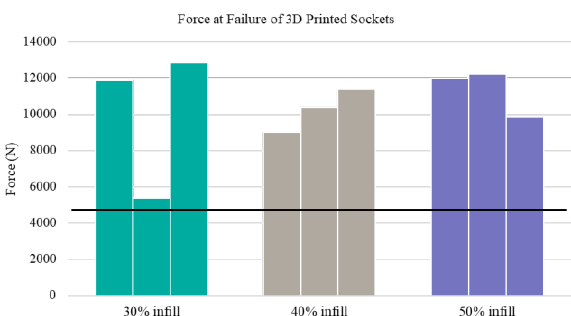
Figure 5. All 3D printed transtibial sockets failed above the ISO standard for this condition.